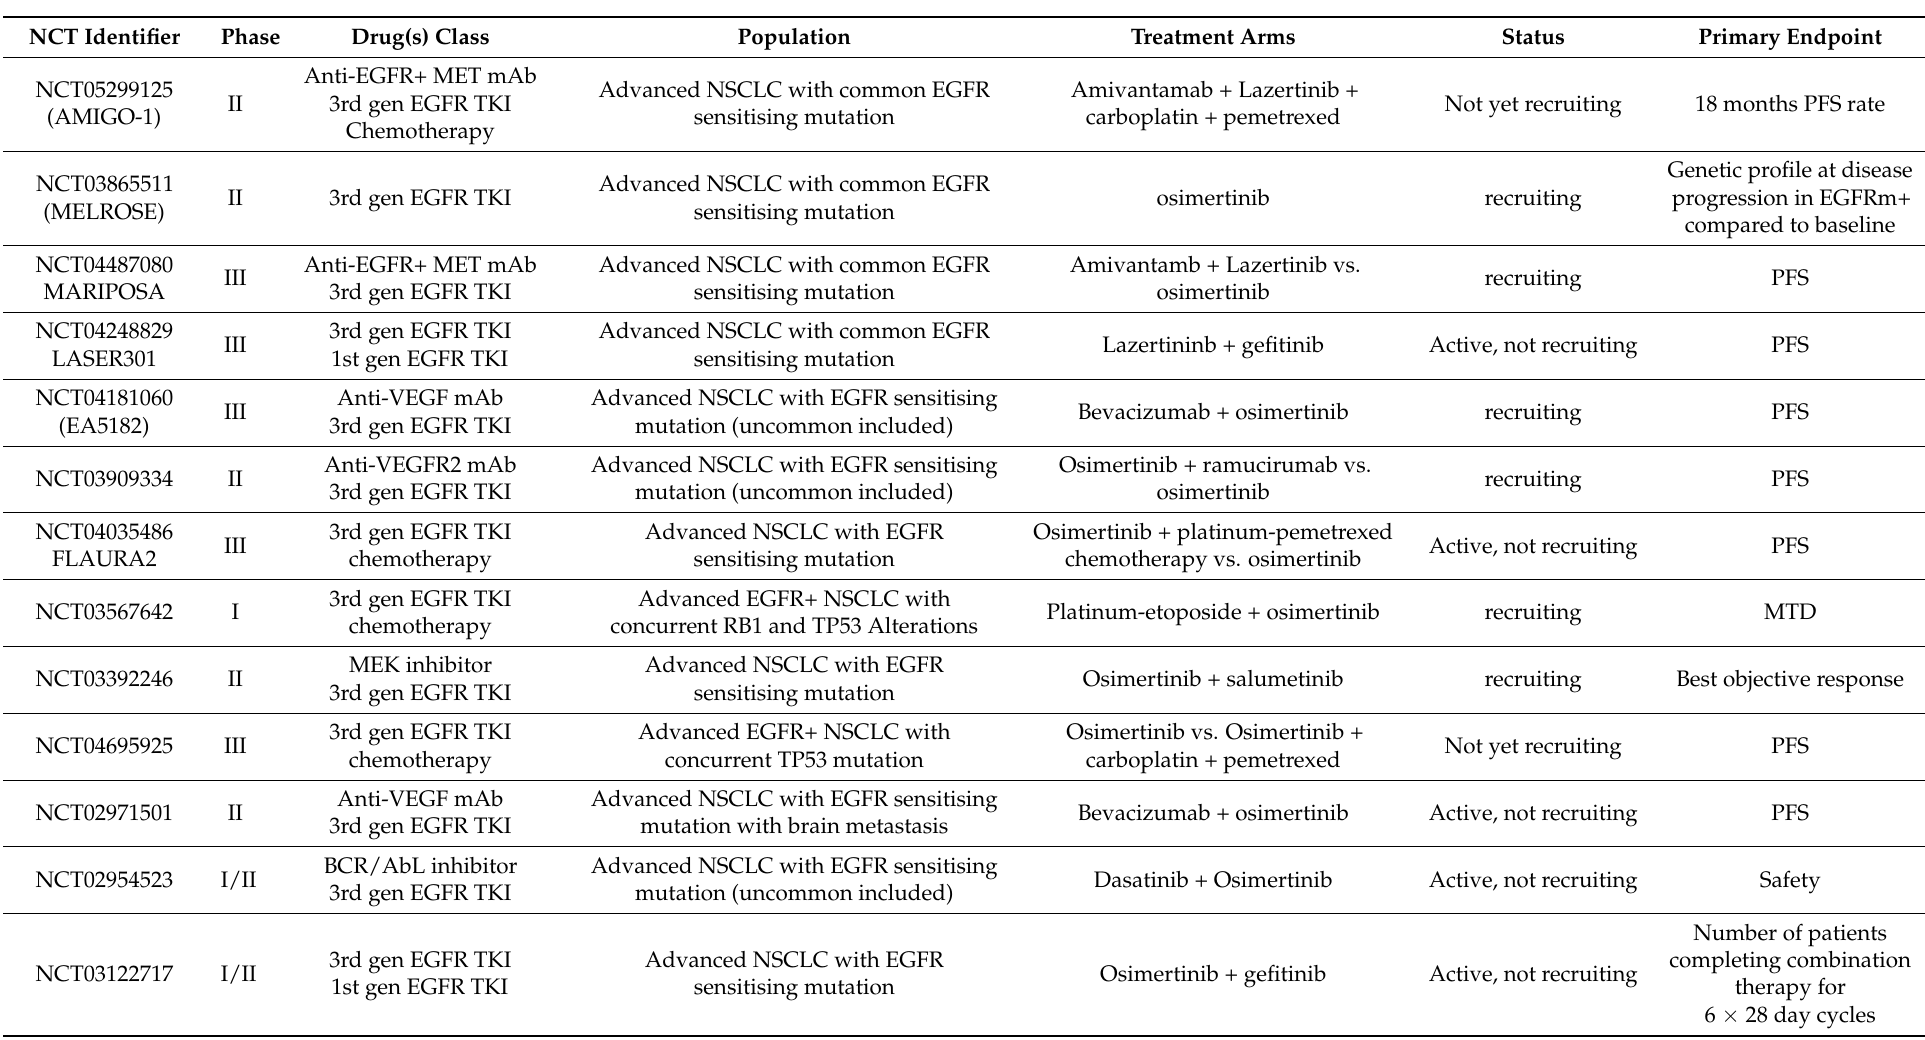
Table 2. Ongoing clinical trials in treatment naïve EGFR-mutated advanced